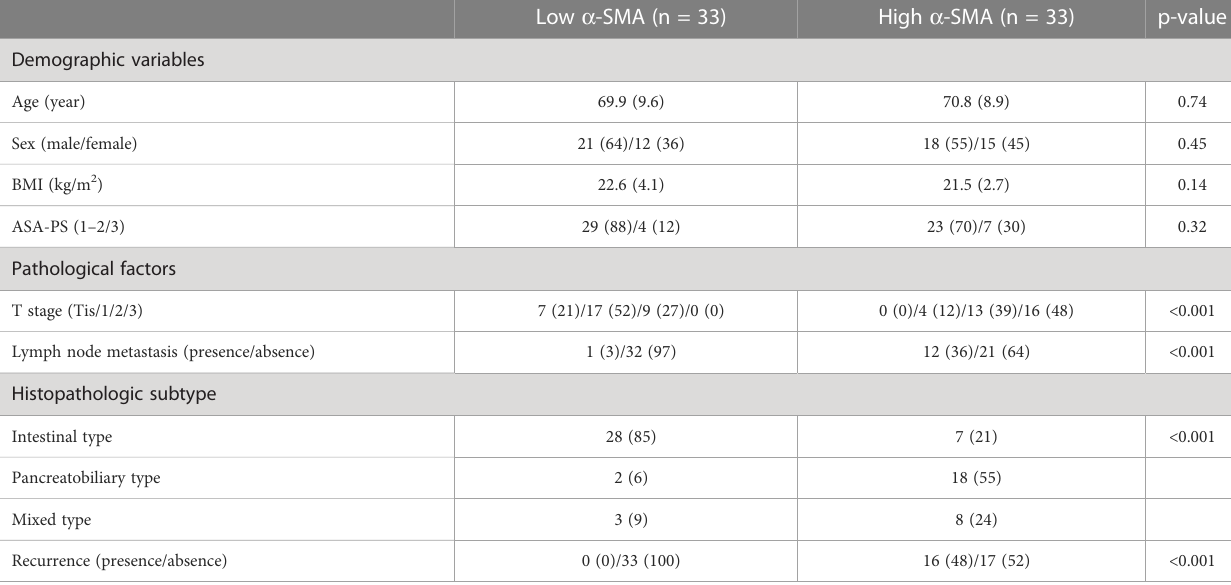
TABLE 5 Relationship between a SMA expression and clinicopathological